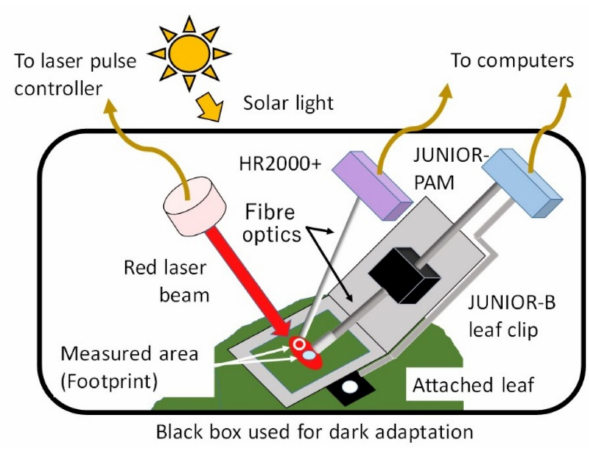
Figure 1. Schematic diagram for the measurement of ChlF (Chlorophyll Fluorescence) parameters using PAM (Pulse Amplitude-Modulated) and FLD-LISP (Fraunhofer Line Depth and Laser-Induced Saturation Pulse) methods. The focal point (measurement area, white circle on leaf) of fibre-HR2000+ was set at a distance of 2 mm from that of the fibre-PAM (light blue filled circle) to avoid the influence of saturation pulse light and shadow of the fibre-PAM. Red filled area on the leaf is the footprint of the red laser beam. A black box was used to switch between dark condition and solar light. The timing and duty ratio of the red laser radiation were maintained by a laser pulse